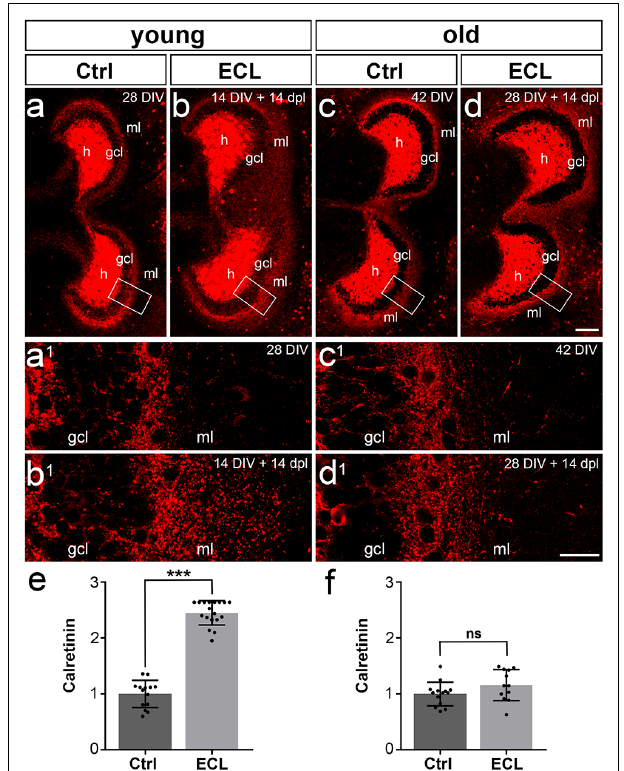
FIGURE 2 | Commissural/associational sprouting is attenuated in cultures lesioned at 28 days in vitro . (A–D) Double cultures of wild type mouse hippocampus immunolabeled for calretinin (red). (A) Overview of a non-denervated young double culture at DIV 14 (control, Ctrl). Calretinin-positive mossy cells were found in the hilus (h) of the culture and mossy cell axons were present in the inner part of the molecular layer (ml). (B) Fourteen days post-lesion (dpl) mossy cell axons were found throughout the ml. (A1,B1) Higher magnification of the boxed areas in (A,B) reveals a robust ingrowth of mossy cell axons into the outer part of the ml ( A1 compared to B1 ) after entorhinal cortex lesion (ECL). (C) Overview of a non-denervated old double culture at DIV 28 (Ctrl). Calretinin-positive mossy cells were found in the hilus (h) of the culture, while mossy cell axons were found in the inner part of the molecular layer (ml). (D) Fourteen days post-lesion (dpl) mossy cell axons in old cultures stayed within the inner zone of the molecular layer. (C1,D1) Higher magnification of the boxed areas in (C,D) reveals only a very limited sprouting response ( C1 compared to D1 ) after ECL. Compared to young cultures ( B1 compared to D1 ), the sprouting response is greatly attenuated. (E) Quantitative analysis of the axonal sprouting response into the ml in young cultures. Control (Ctrl) was set to 1. A highly significant sprouting response was seen in denervated young cultures compared to non-denervated control cultures (Ctrl: 1.00 ± 0.24, ECL: 2.45 ± 0.22). (F) Quantitative analysis of the axonal sprouting response into the ml in old cultures. Control (Ctrl) was set to 1. No significant (ns) sprouting response was seen in denervated old cultures compared to non-denervated control cultures (Ctrl: 1.00 ± 0.21, ECL: 1.16 ± 0.28). Mann–Whitney test; mean ± SD; *** p < 0.001; n = 14–18 hippocampi per group in young cultures (data of young cultures from Del Turco et al., 2019) and n = 12–14 hippocampi per group in old cultures; gcl, granule cell layer. Scale bars: 100 µ m (A–D) ; 25 µ m (A1–D1)